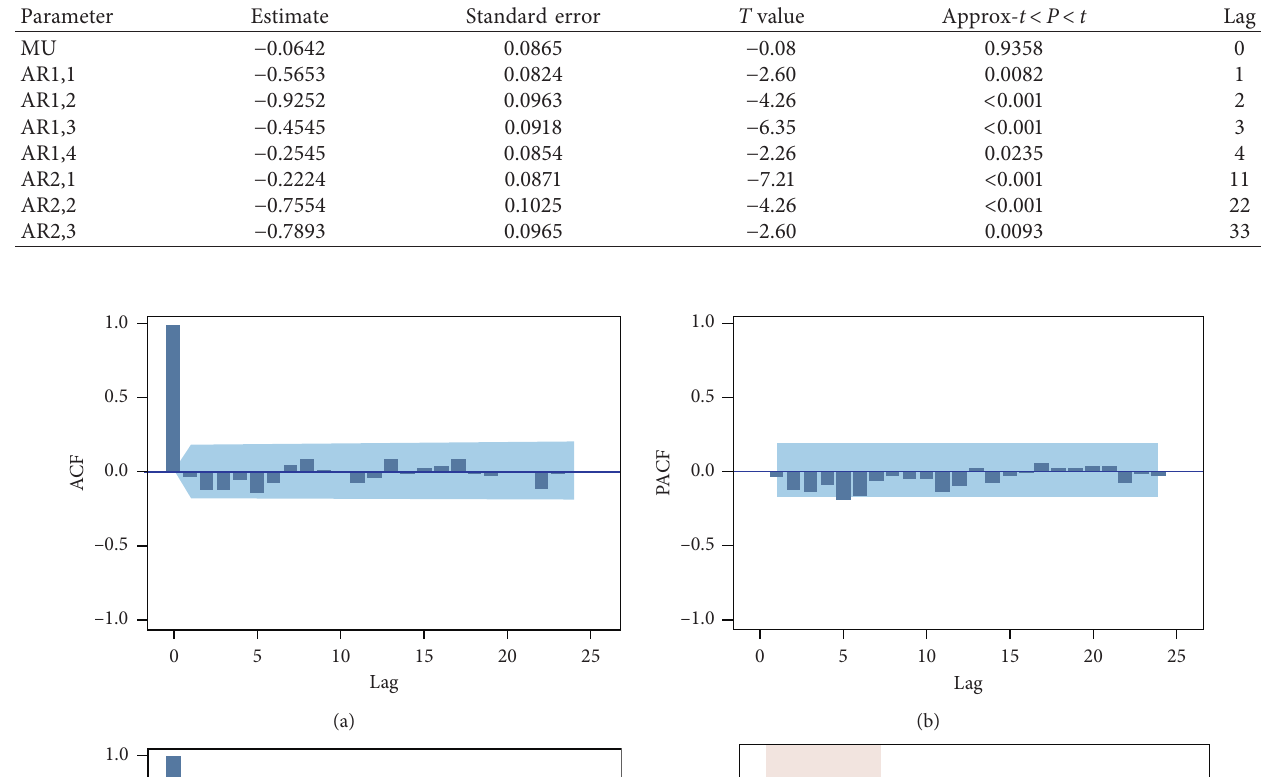
Table 5: Maximum likelihood estimation results of the fintech ARIMA model.